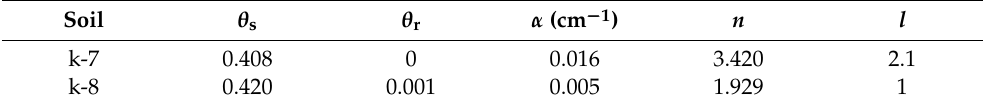
Figure 2. ( a ) Soil water retention curves (main wetting), and ( b ) unsaturated hydraulic conductivity curves for the k-7 and k-8 soils. Table 1. Parameters applicable to the main wetting